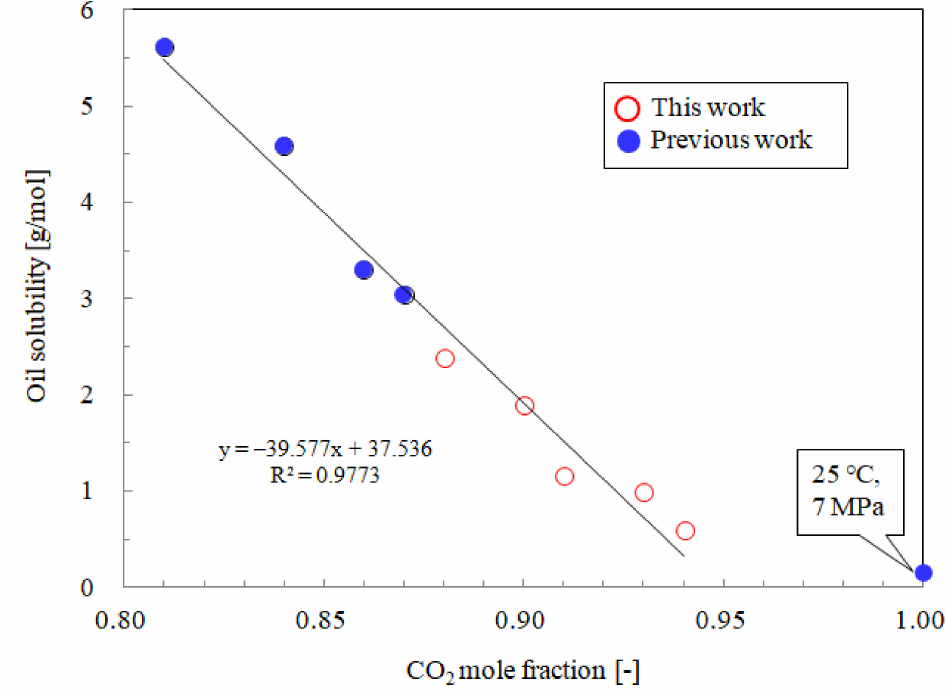
Figure 7. Relationship between the oil solubility and the CO 2 mole fraction of CO 2 -expanded hexane at 25–26 ◦ C and 5.0–5.2 MPa, in addition to that of liquid CO 2 at 25 ◦ C and 7 MPa. Previous work is shown in ref.